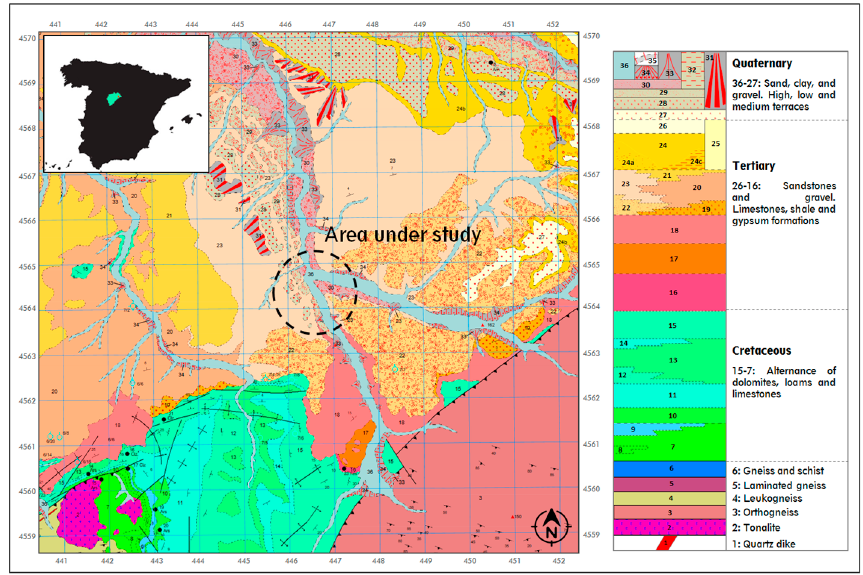
Figure 1. Geological composition of the area under study [21].